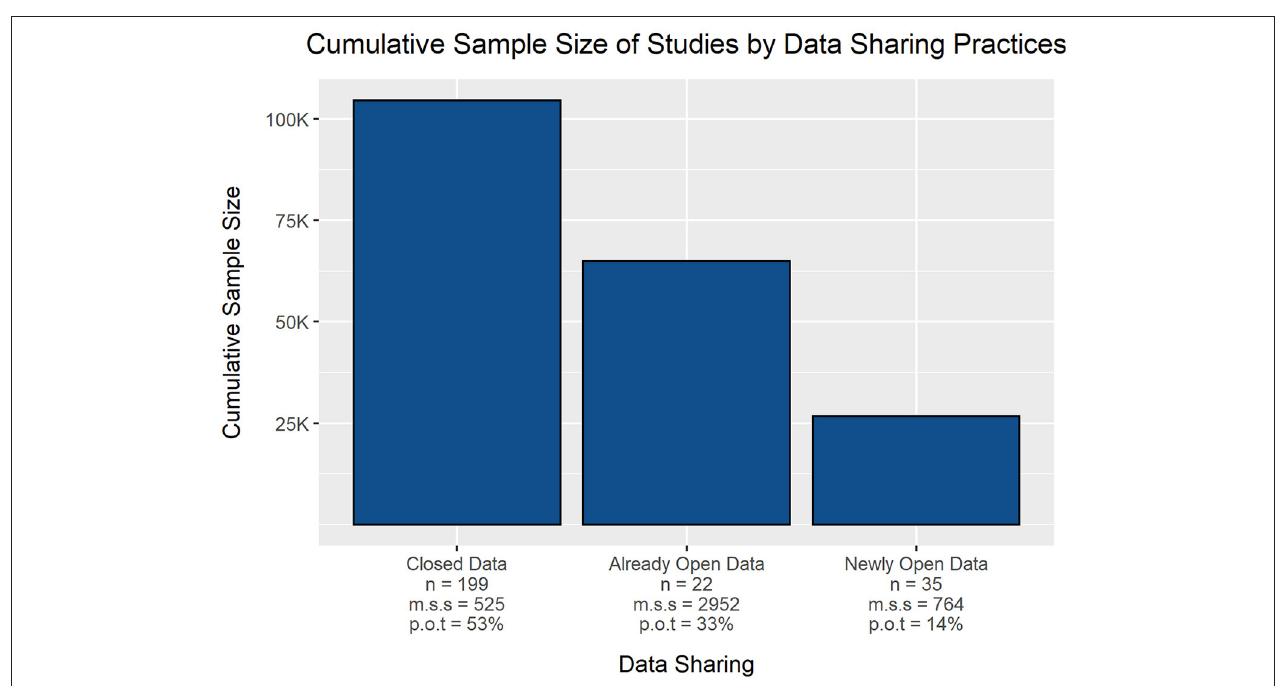
FIGURE 3 | A barchart showing the cumulative sample size of household-level datasets used by articles, disaggregated by data-sharing practice. Number of articles is represented by “n,” mean sample size represented by “m.s.s,” and percentage of total samples collected represented by “p.o.t”.